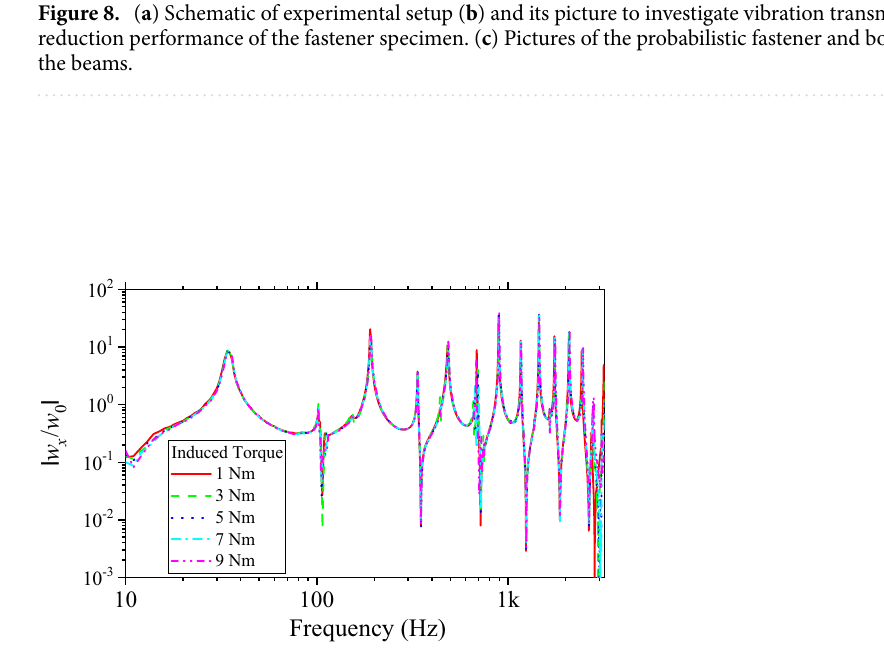
Figure 9. Vibration response of beam according to bolts tightening